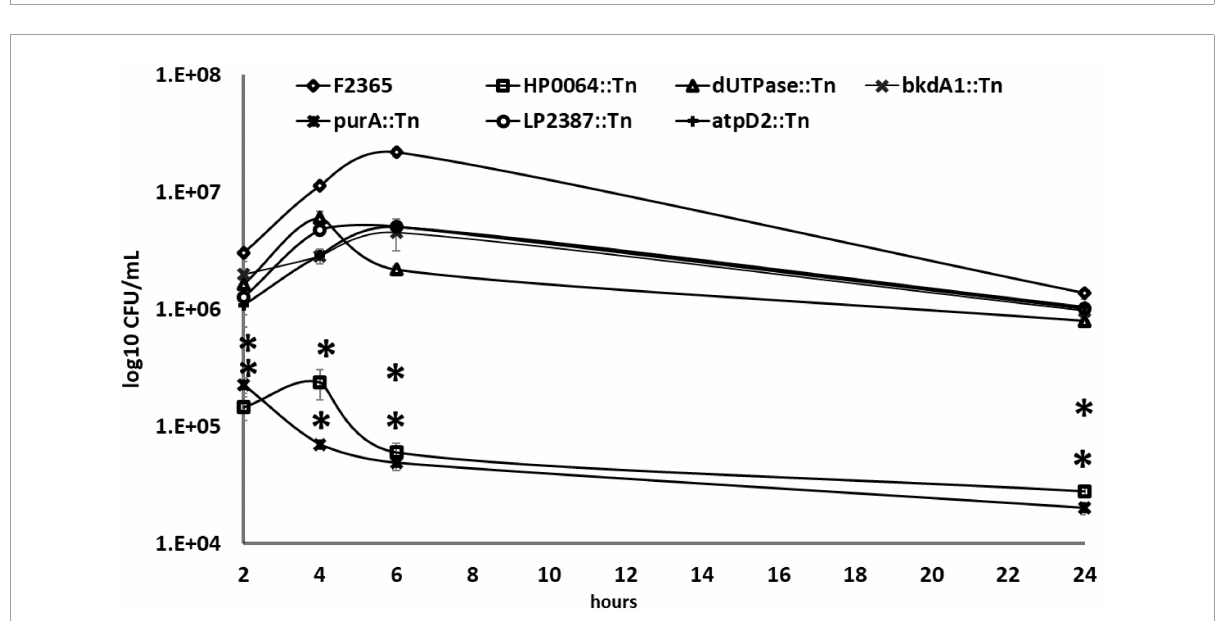
FIGURE5 Intracellular growth of Tn-mutants compared to the wild-type L. monocytogenes strain in J774 macrophage-cells using an MOI of 10:1. At 2, 4, 6, and 24 h pot-infection, cells were lysed, and CFUs were enumerated. The experiment was repeated twice with three replicates each. Error bars are the standard error of mean. Two-way ANOVA and Dunnett’s multiple comparison test were used to measure the statistical significance between Tn-mutants and wild-type at different time points. Asterisks (*) indicate statistically significant differences ( P < 0.05).